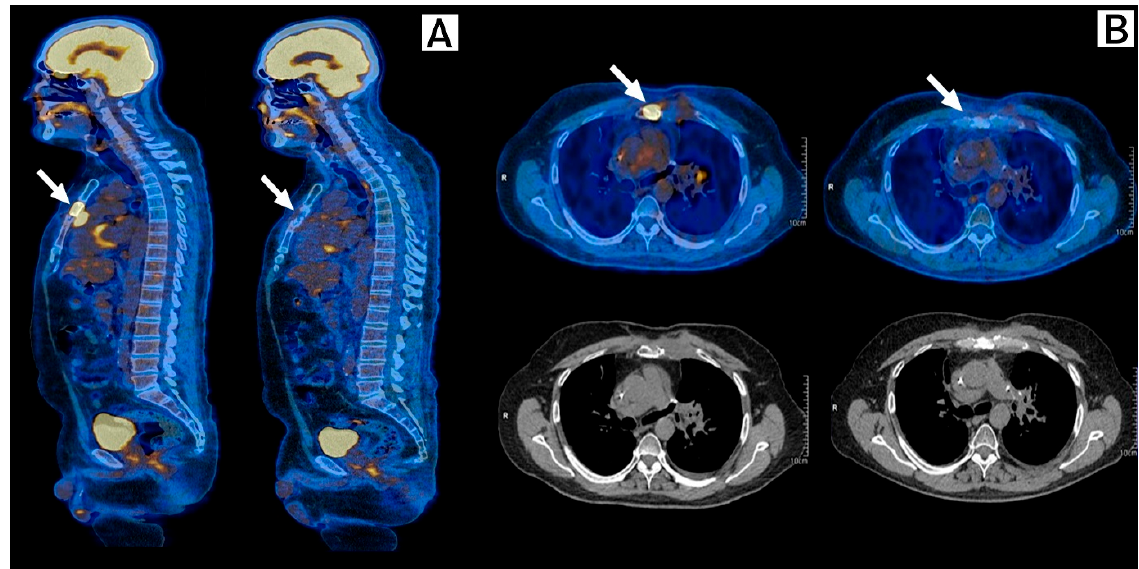
Figure 4. Response to immunotherapy rechallenge. FDG-PET-Scan, Baseline ( left ) and 6 months after ( right ) after initiation of Ipilimumab plus Nivolumab. ( A ) Sagittal plane, and ( B ) Transversal plane. Arrows show a partial response with metabolic response of sternum and costochondral lesions when compared to prior scans, demonstrating a response to Ipilimumab plus Nivolumab.